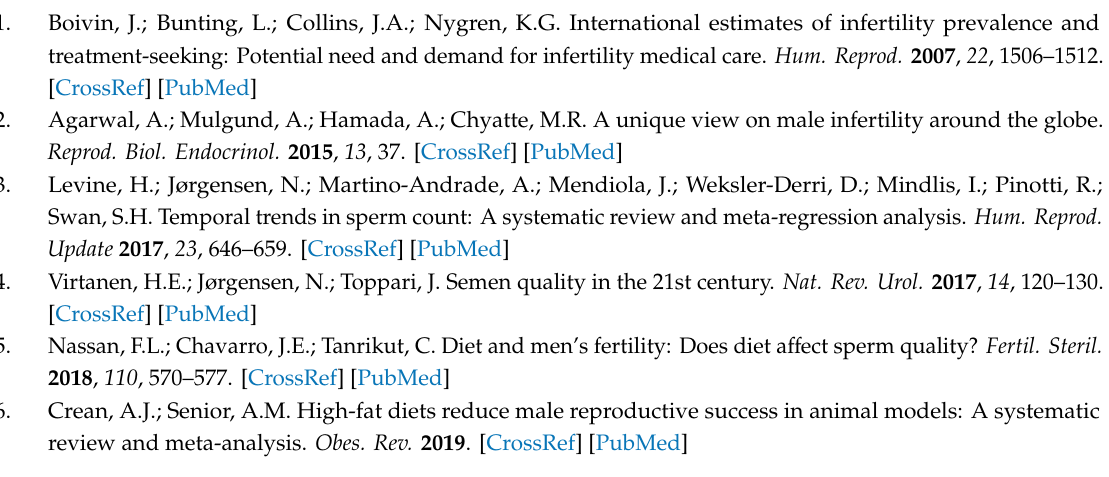
Figure S1: Before–after graphs for ( A ) concentration, ( B ) total motility, and ( C ) progressive motility at 0 and 21 days obtained for each experimental group. “M” and “P” refers to the experimental groups: Control and maltodextrin respectively. “M#” indicates the number of the male; Figure S2: ( A ) PCA analysis for Computer Assisted Sperm Analysis (CASA) variables for probiotic-fed group. ( B ) Representation of the experimental group in a principal component plane; Table S1: Weight values (mean ± s.e.) for the groups before and after treatment; Table S2: Sperm quality values (mean ± s.e.) for the groups before and after treatment; Table S3: novel tank values for behavior estimators (mean ± s.e.) for the groups before and after